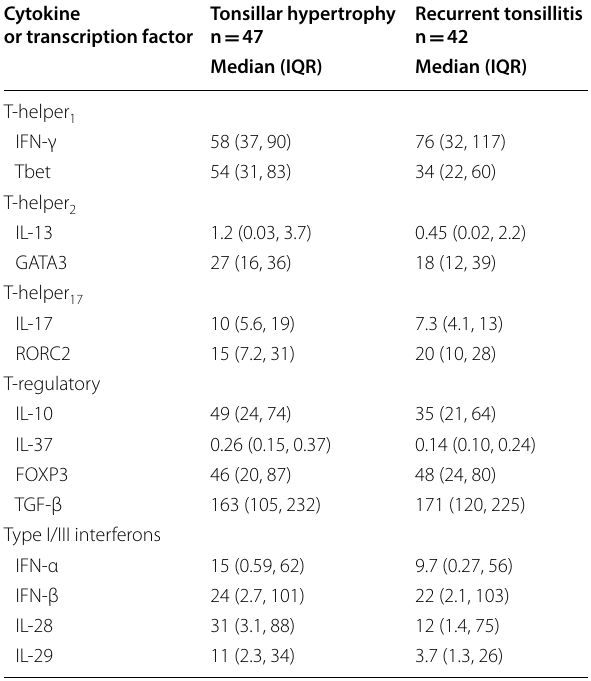
Table 3 Intratonsillar cytokine and transcription